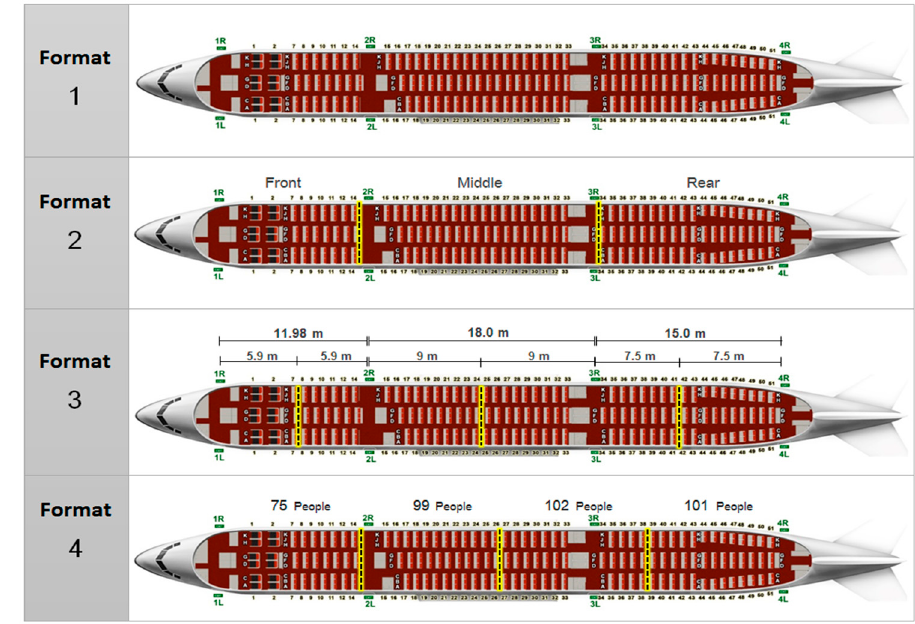
Figure 1. Seat row assignment in each